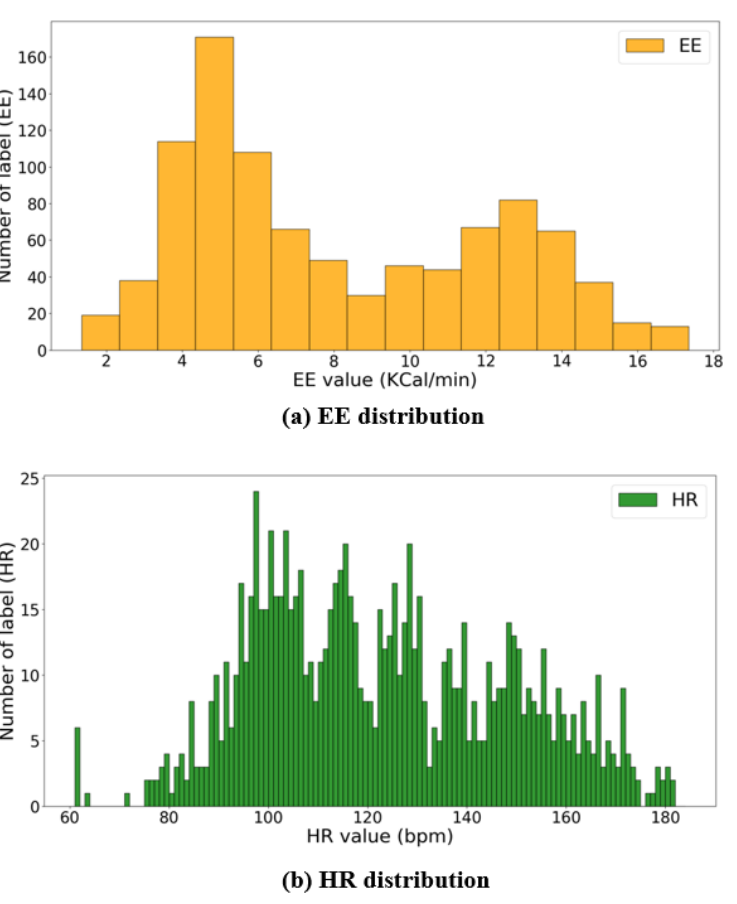
Figure 6. Distributions of HR and EE labels: ( a , b ) show the number of EE values per KCal/min and HR values per bpm,